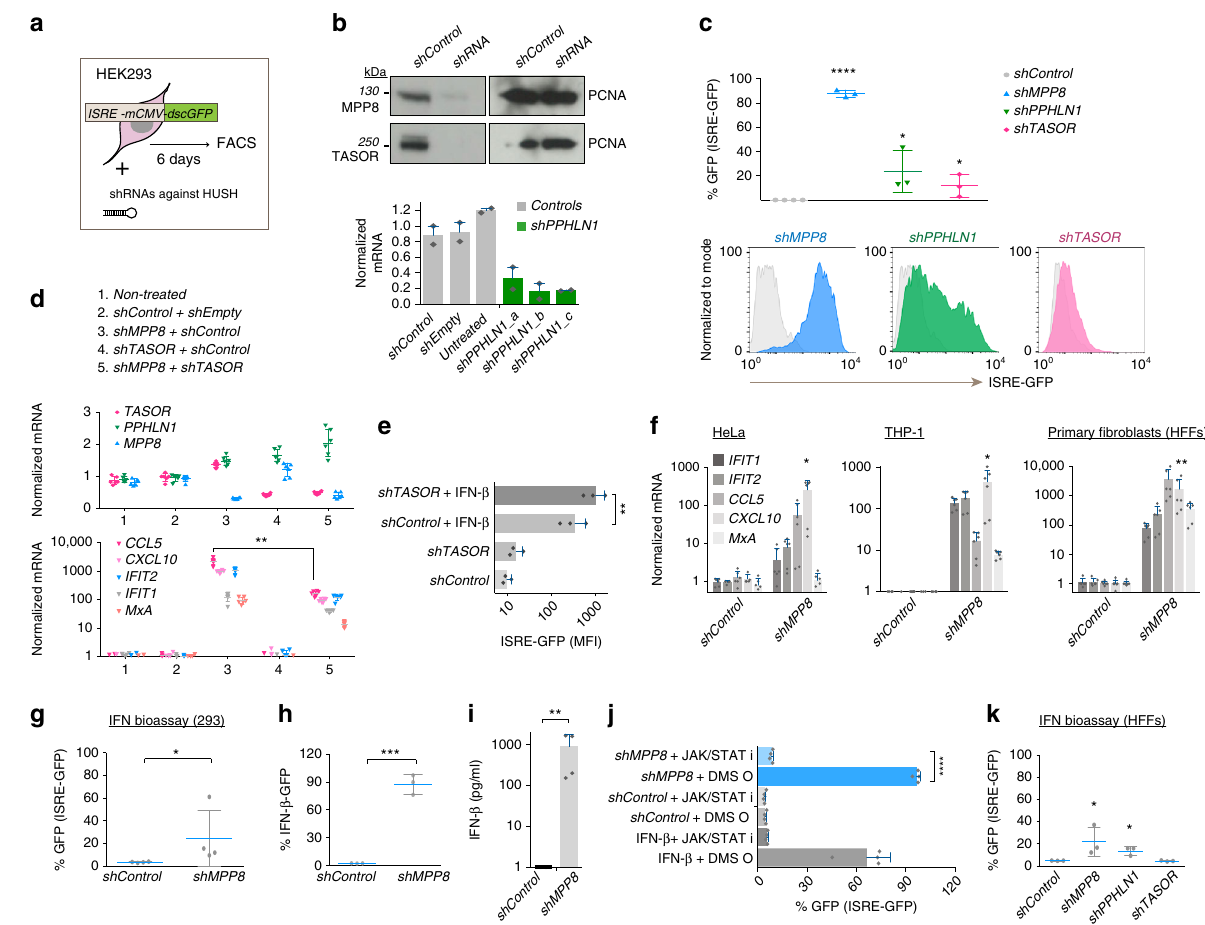
Fig. 1 The HUSH complex regulates the type I IFN response. a Diagram of IFN induction assay: HEK293 cells harbor an integrated IFN reporter expressing destabilized GFP (dscGFP). ISRE: IFN-stimulated response elements; mCMV : minimal CMV promoter. GFP was assessed 6 days post shRNAs. b Western blot and qRT-PCR to assess HUSH depletion day 4 post shRNAs. PPHLN1 mRNA normalized to GAPDH . N = 3 biologically independent samples